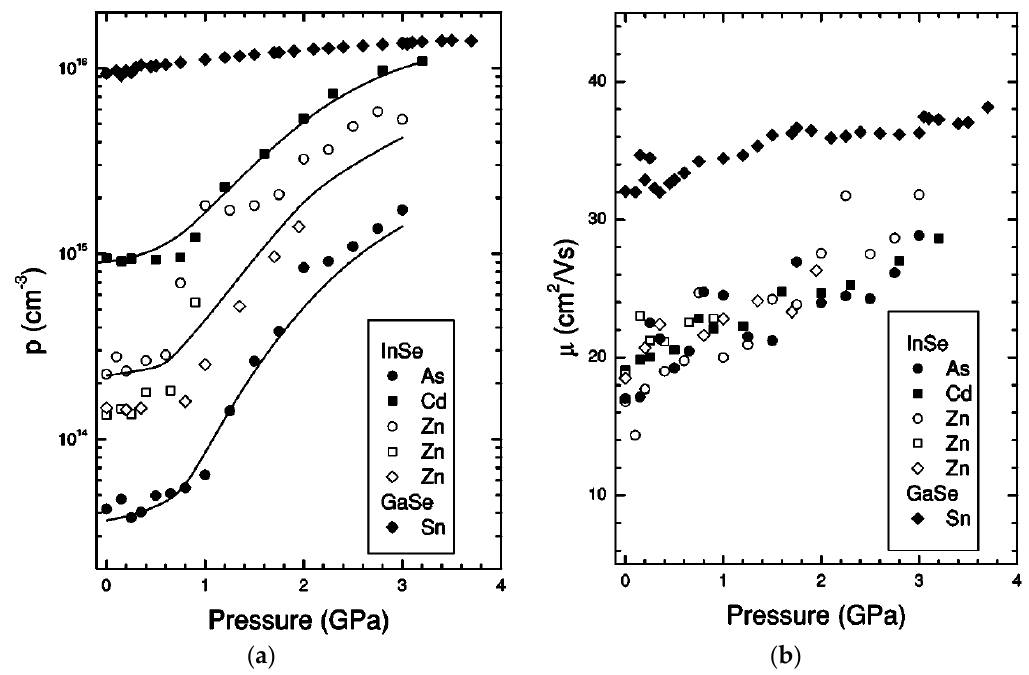
Figure 21. ( a ) Pressure dependence of the hole concentration in p-type γ -InSe and ε -GaSe. ( b ) Pressure dependence of the hole mobility in p-type γ -InSe and ε -GaSe.